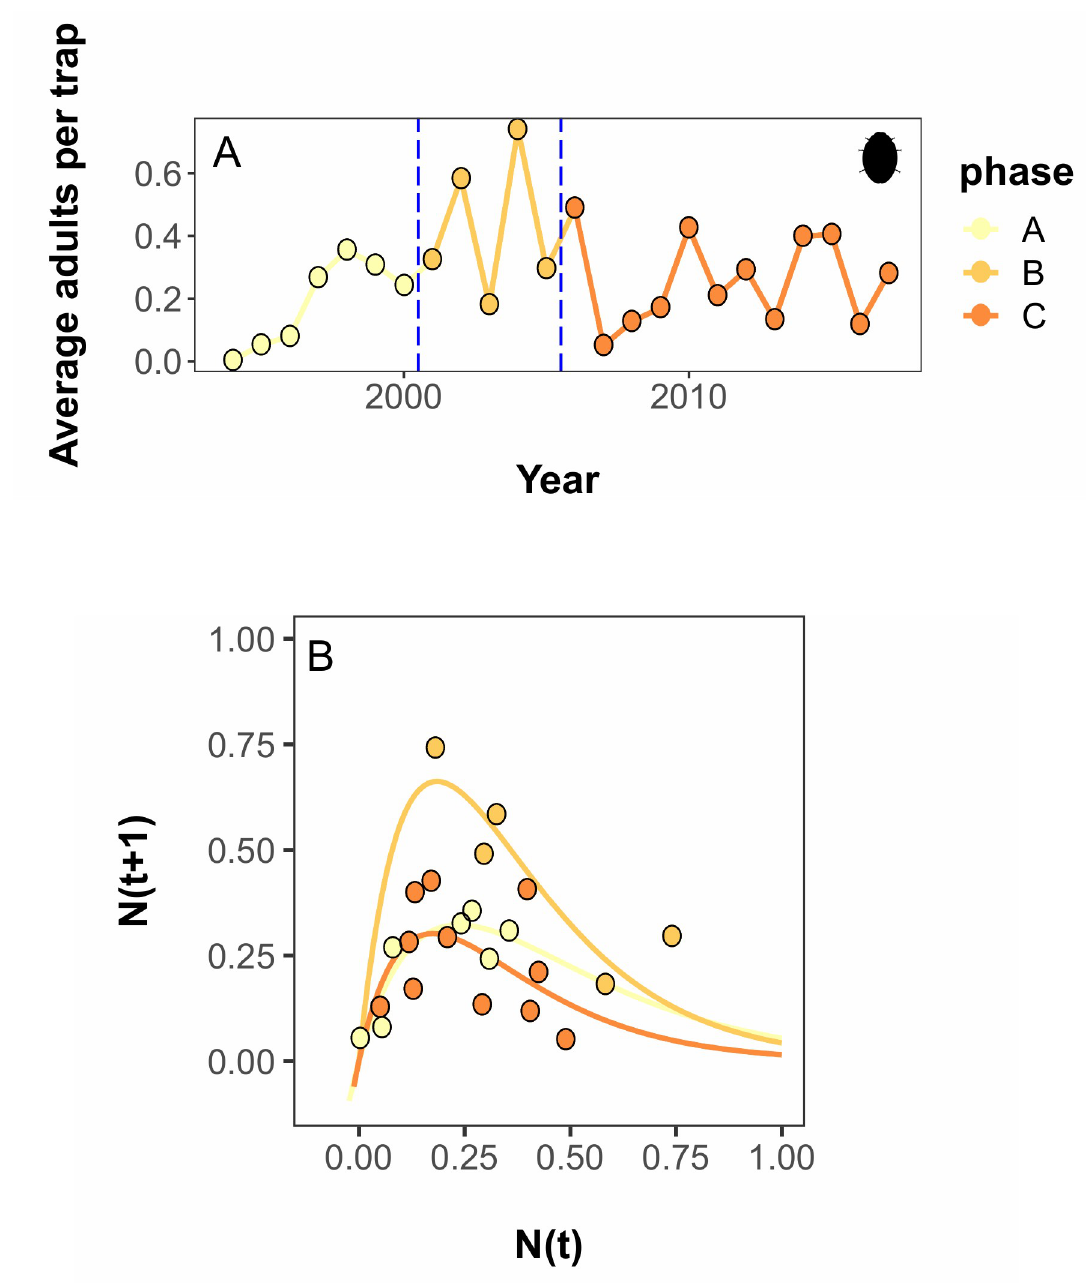
Fig 3. Dynamic Shift Detector breaks and Ricker model fits for an invasive species. Population data documenting the invasion of multicolored Asian ladybeetle in Michigan, USA from 1994–2017. A) Time series data showing the average number of adults captured, per trap, per year. Vertical blue lines indicate years in which dynamic shifts occurred, as estimated by the Dynamic Shift Detector algorithm. B) Ricker fits of time series data segments. Ladybeetle art by M. Broussard, used under a CC-BY 3.0 license.